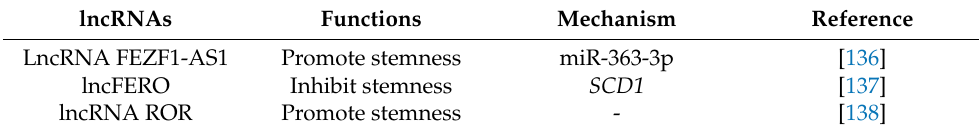
Table 4. Related lncRNAs in GCSCs.